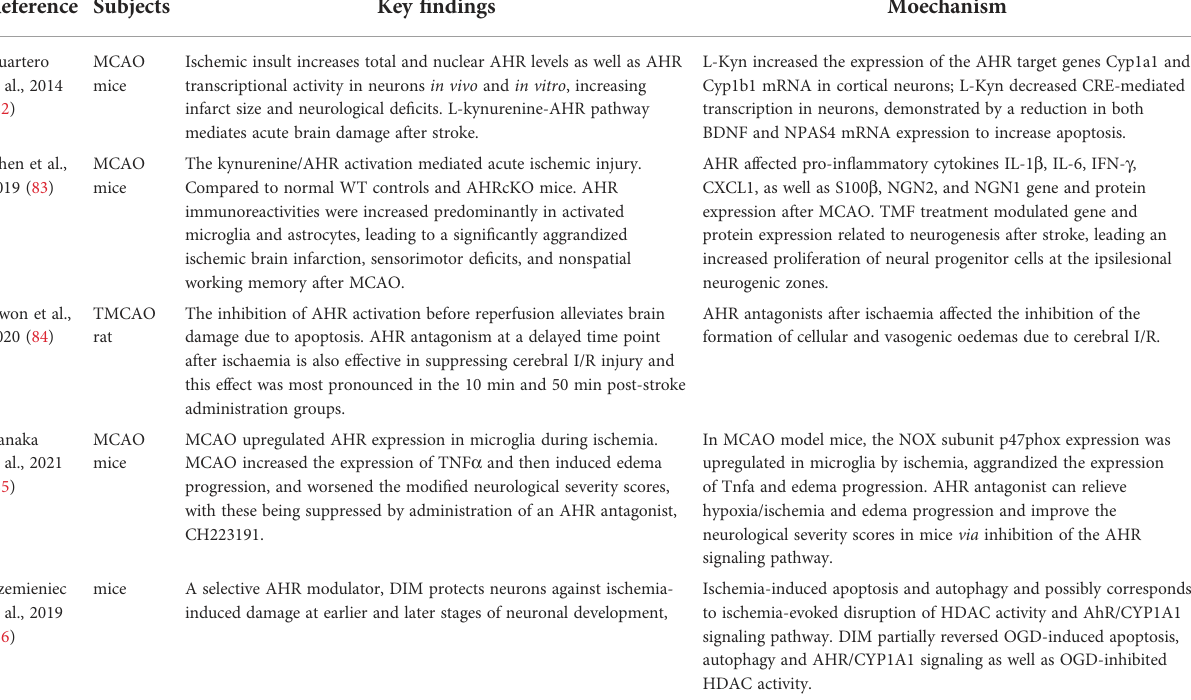
TABLE 2 A summary of the role of AHR in cerebral